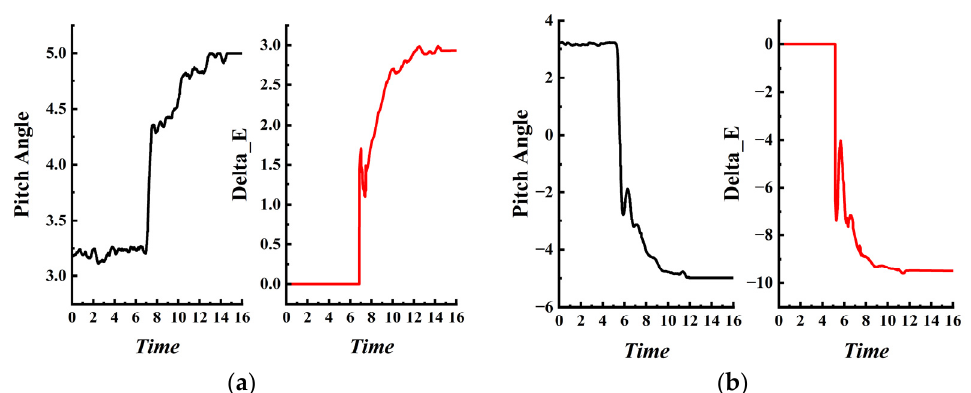
Figure 27. The pitch angle and tail deflection angle time history curves at wind speed 24 m/s: ( a ) 5 °and ( b ) − 5 °.